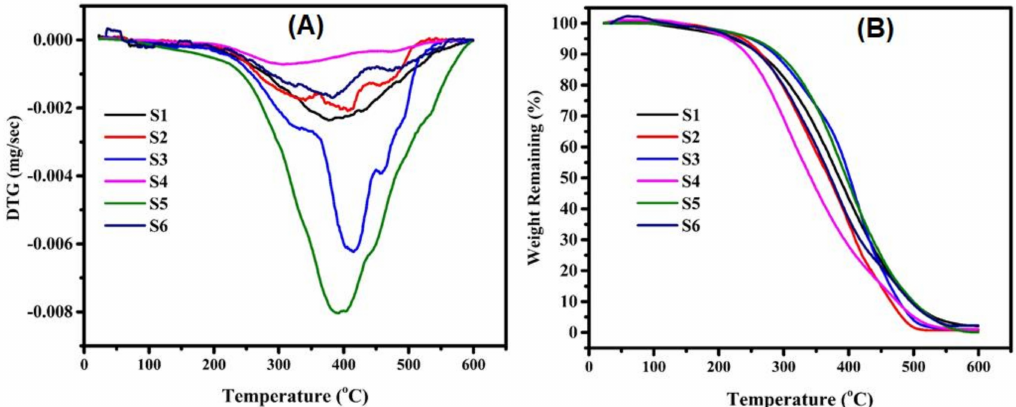
Figure 7. ( A ) Derivative thermogravimetric (DTG) and ( B ) thermogravimetric analysis (TGA) curves for oil recovered from sesame seeds roasted with different methods: S1: unroasted, S2: local market roasted, S3: stovetop pan, S4: oven, S5: microwave, and S6: electric frying